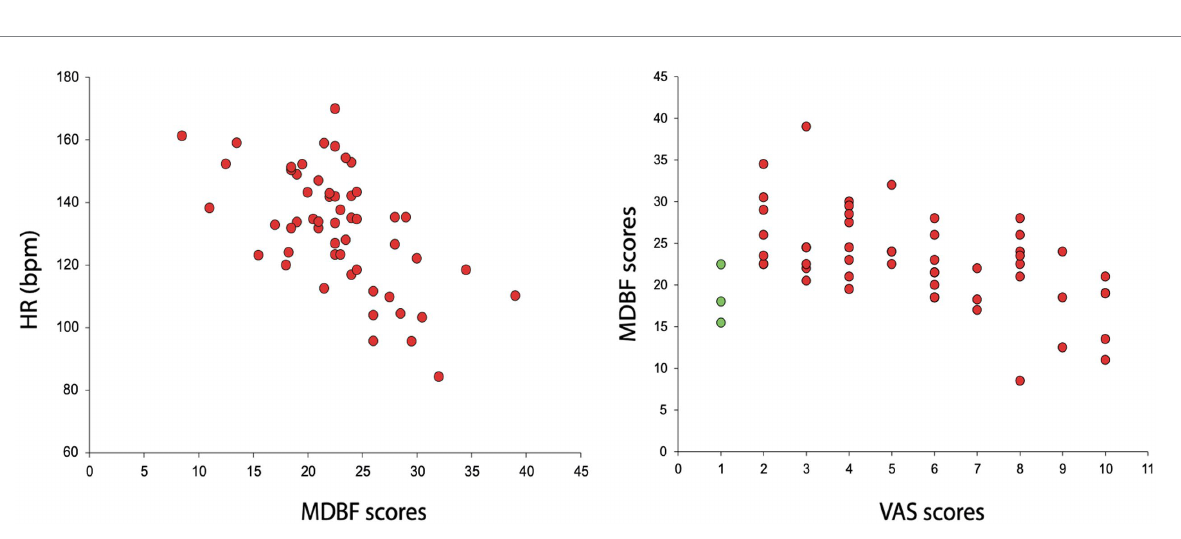
FIGURE 3 HR and RU correlation (left) , VAS and MDBF correlation (right) . Negative HR and RU Spearman’s rank correlation across participants and all three performances. Shown are all three RU scores and HR values for each participant (left) . Musicians with higher HR scores reported being less calm. Spearman’s rank correlation of negative VAS and RU (right) calculated across participants and all three performances. Shown are all three RU and VAS scores for each participant. The green dots represent the VAS scores of the only participant who scored all three performances with a 1.